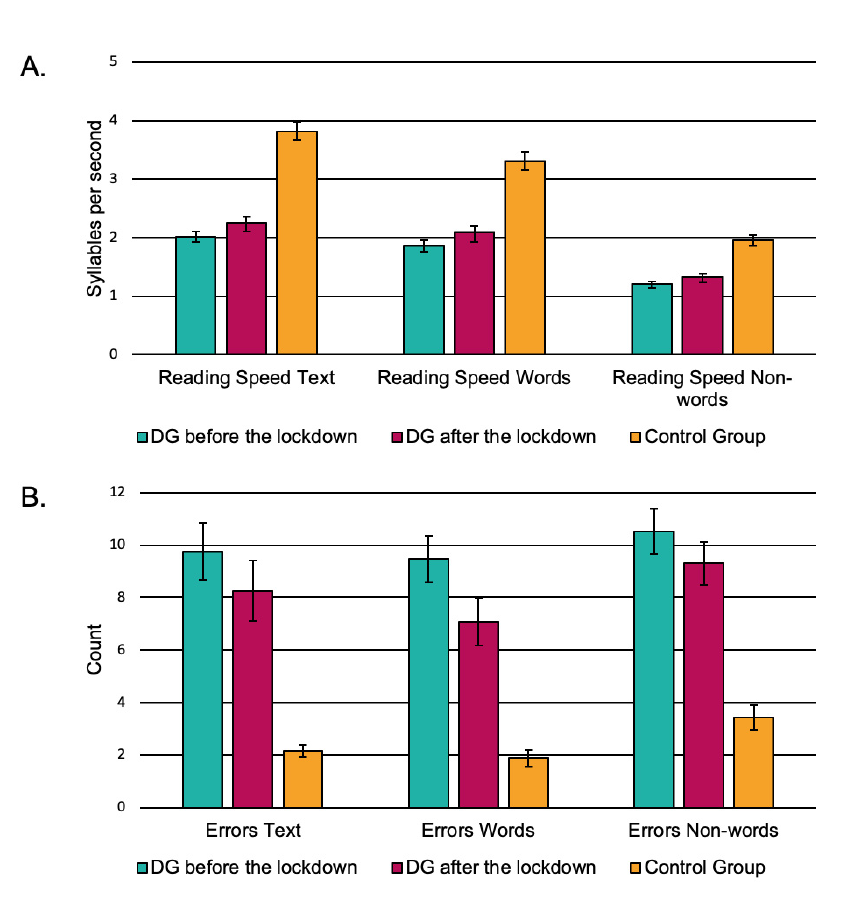
Figure 2. Dyslexia group (DG) and control group reading speed ( A ) and accuracy ( B ) for words, non-words, and text before and after the lockdown. Note: the control group was assessed only after the lockdown; bars represent standard errors.